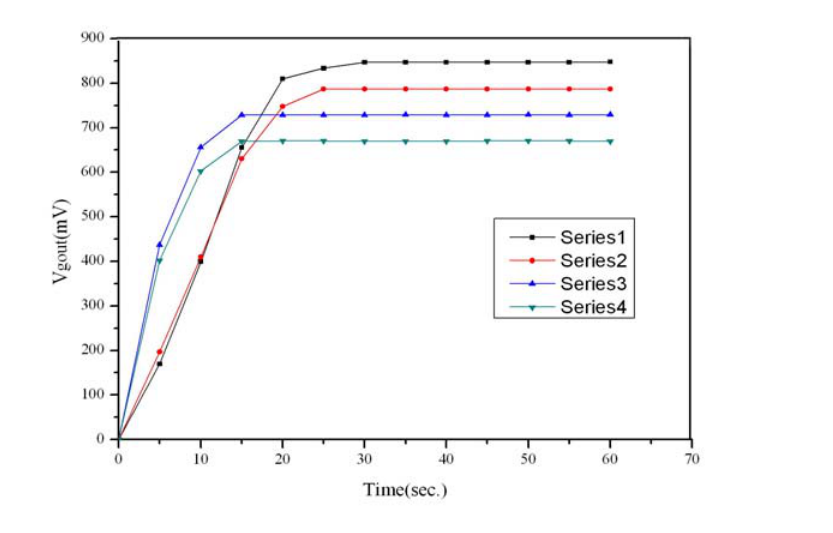
Figure 5. Response time of sensor. Series1, 1.0×10 -6 mol/L atropine, Series2, 1.0×10 -5 mol/L atropine, Series, 3 1.0×10 -4 mol/L atropine, Series 4, 1.0×10 -3 mol/L